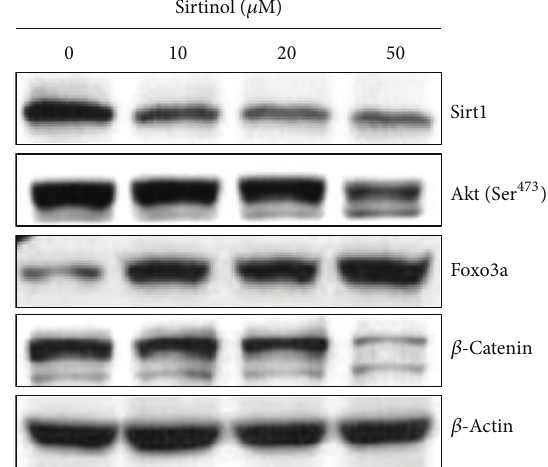
Figure 5: Modulation of protein levels in NSCLC H1299 cells after sirtinol treatment. H1299 cells treated with indicated concentrations (10, 20, and 50 𝜇 M) of sirtinol for 24 h, respectively. The results of Western blot of Sirt1 nonhistone target protein, including FoxO3a, Akt phosphorylation, and 𝛽 -catenin. 𝛽 -Actin as an internal